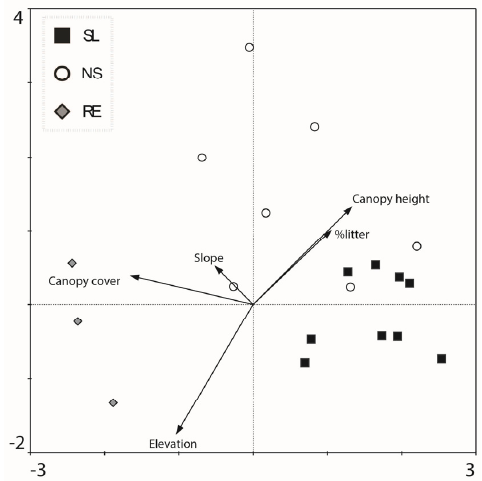
Figure 5. Canonical correspondence analysis (CCA) showing the ordination of the plots and the five most influencing environmental variables. CCA Axis 1 eigenvalue = 0.775; CCA Axis 2 eigenvalue = 0.382.